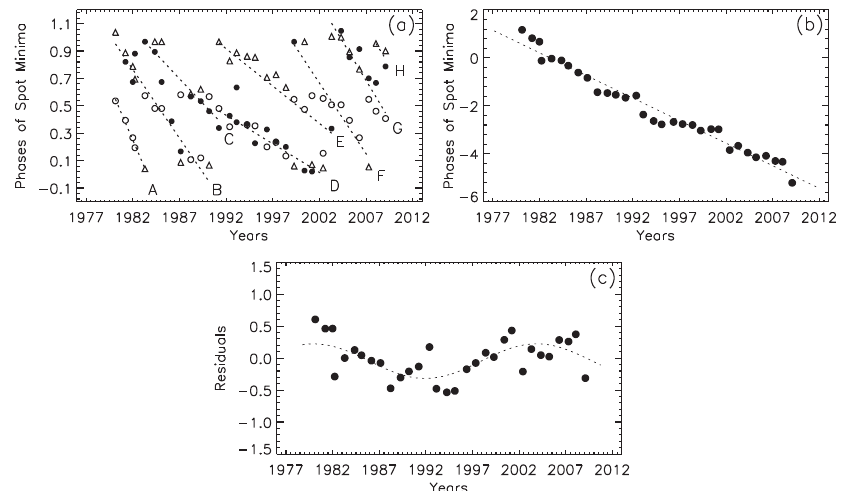
Fig. 4. Panel (a). The movement of spot minimum phases in the years. The letters between A and H are used to show the time range of spot migration on the stellar surface. Panel (b). The phases of spot minima, to which the cycle was added, are represented using a linear least-square fit. Panel (c). The variation of residuals from a linear fit versus the